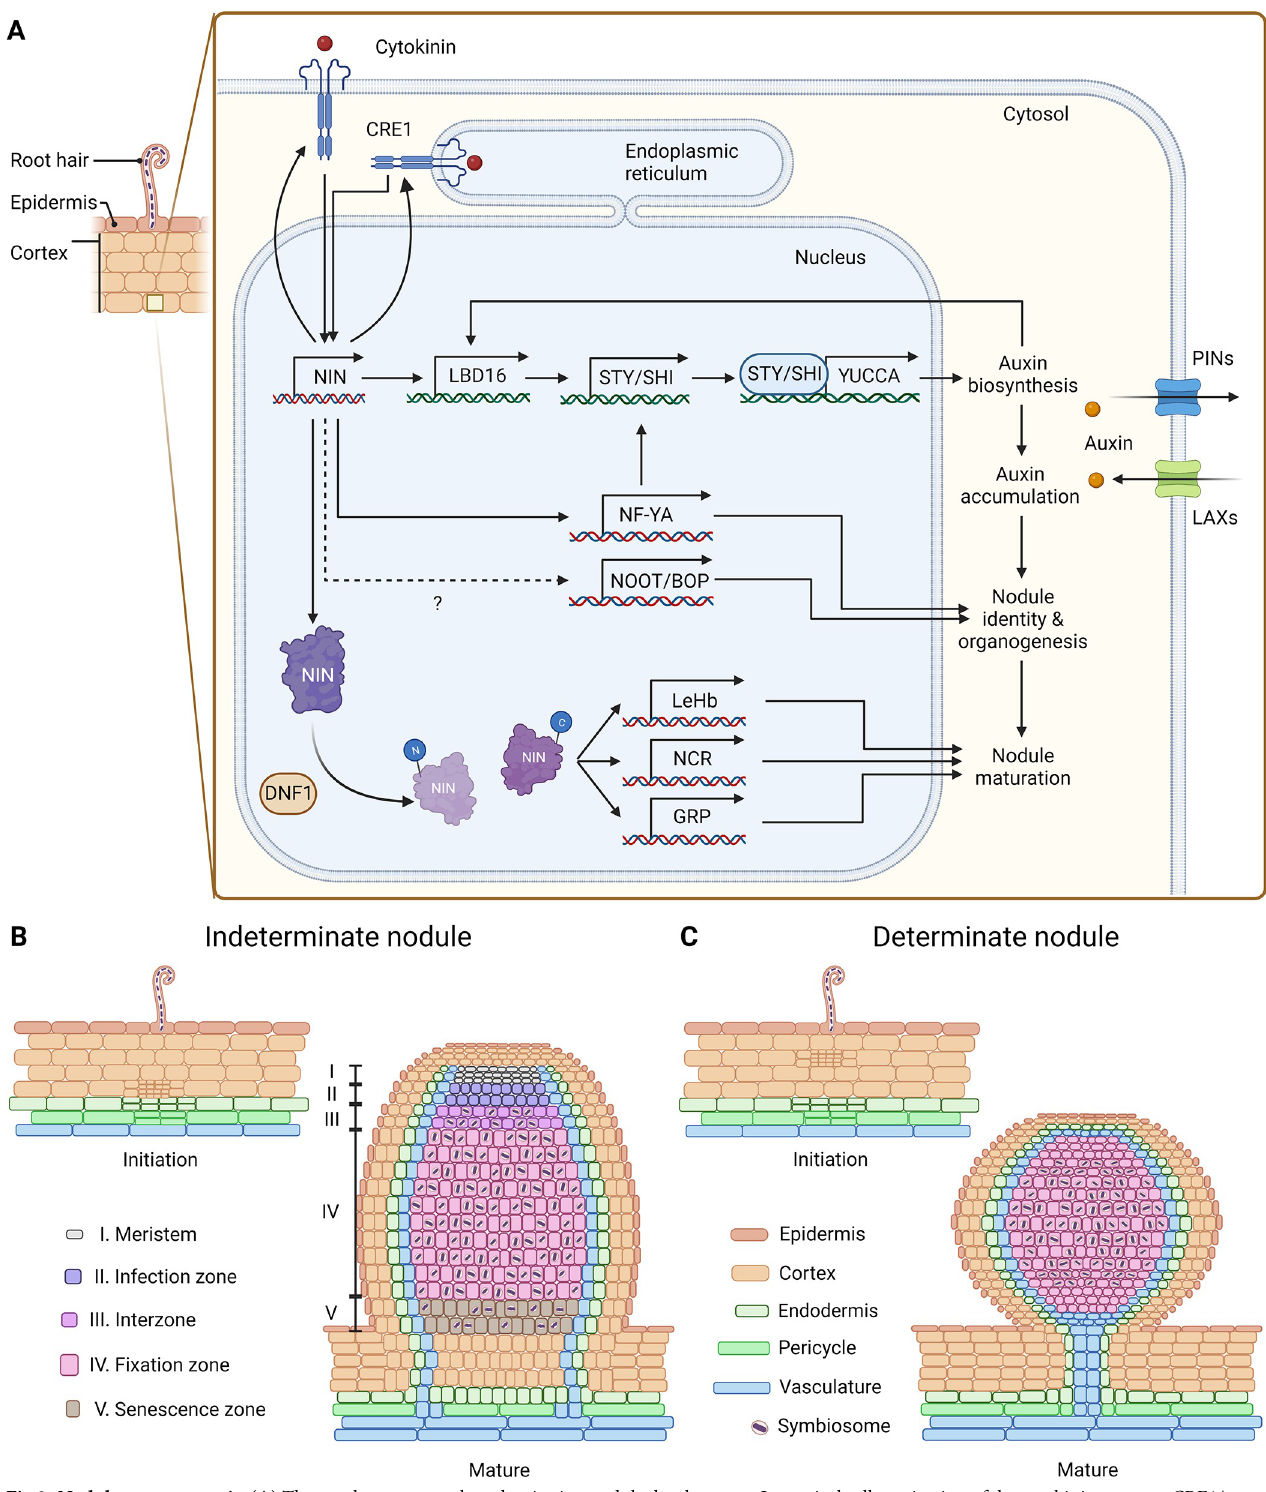
Fig 3. Nodule organogenesis. ( A ) The regulatory network underpinning nodule development. In cortical cells, activation of the cytokinin receptor CRE1/ LHK1 induces NIN expression. In return, NIN promotes the transcription of CRE1 , creating a feedforward loop that can increase cytokinin signalling and NIN accumulation. NIN controls the expression of LBD16 , an auxin-responsive transcription factor that activates the auxin symbiosis pathway via SHI/STY transcription factors, which, in turn, promote expression of YUCCAs , rate-limiting enzymes in auxin biosynthesis. The expression and distribution of auxin